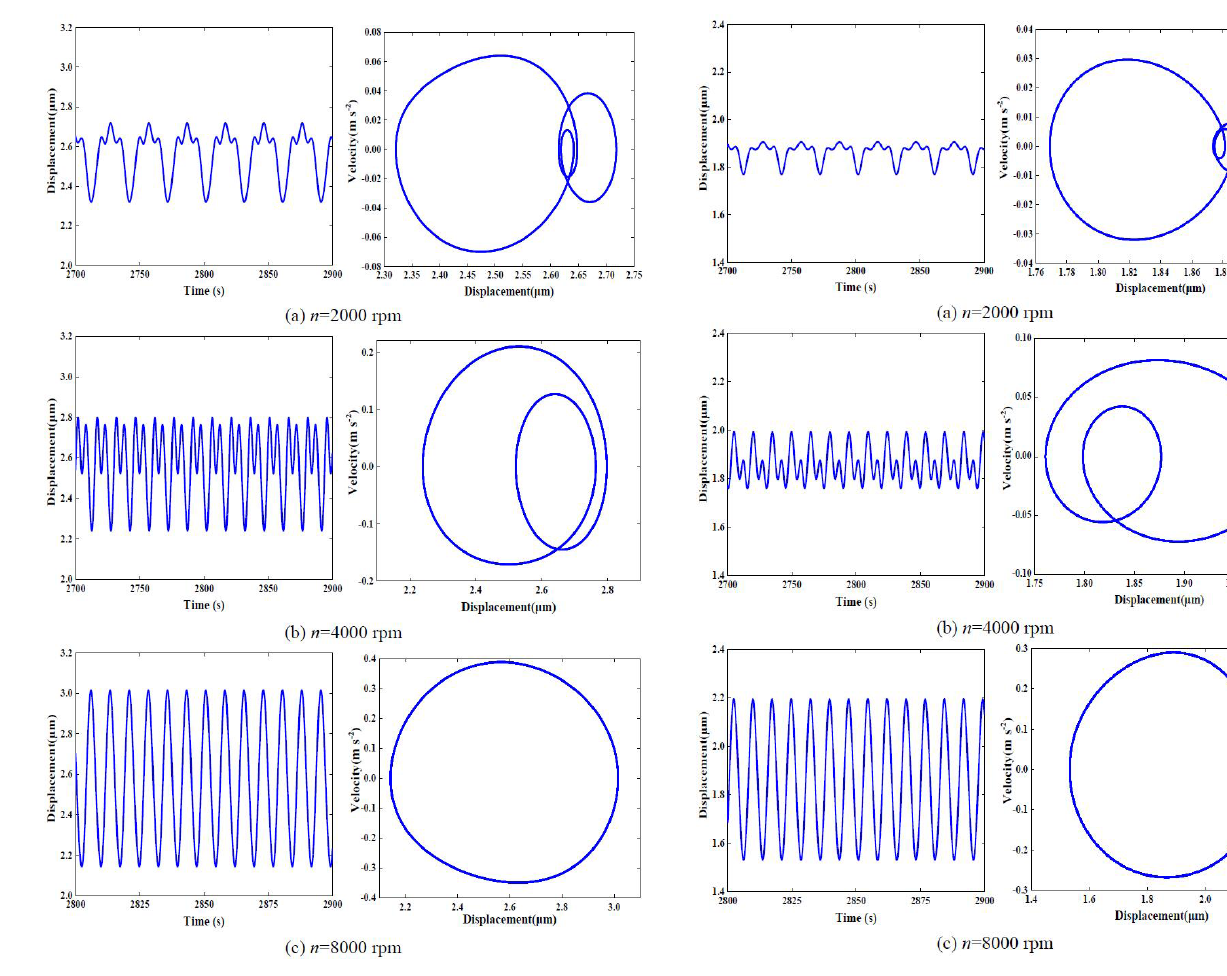
Figure 3. Vibration response of the external meshing pair at differ- ent speeds.